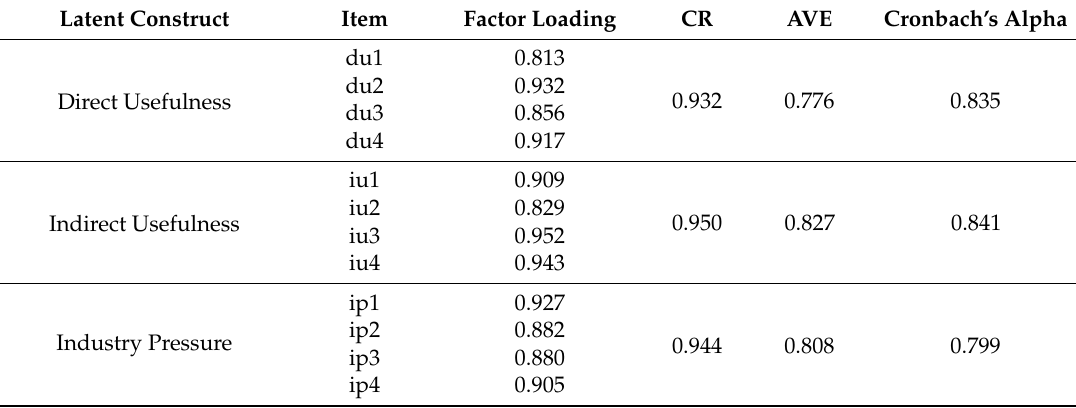
Table 3. Results for reliability and convergent